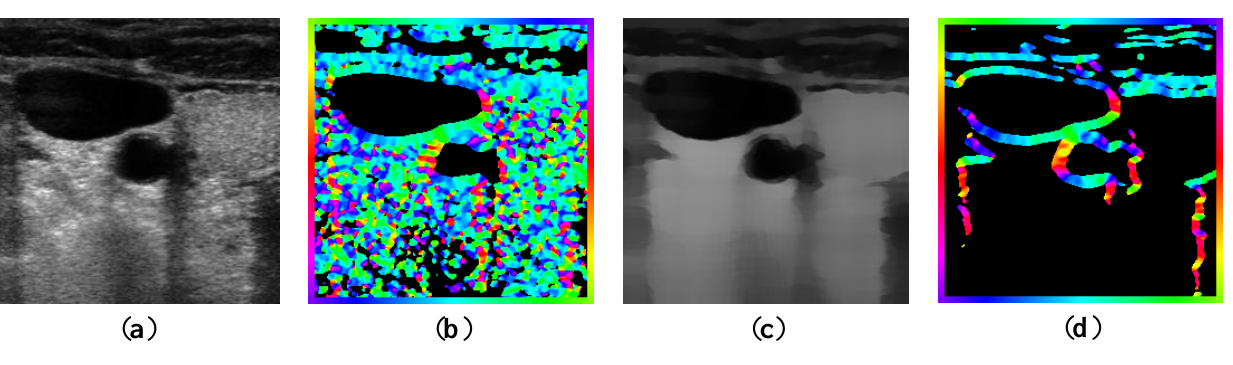
smoothing; ( d ) pixel orientation of the smoothed (SRAD) image. In b and c, the pixel local orientation is represented with colors with respect to the color reference frame.